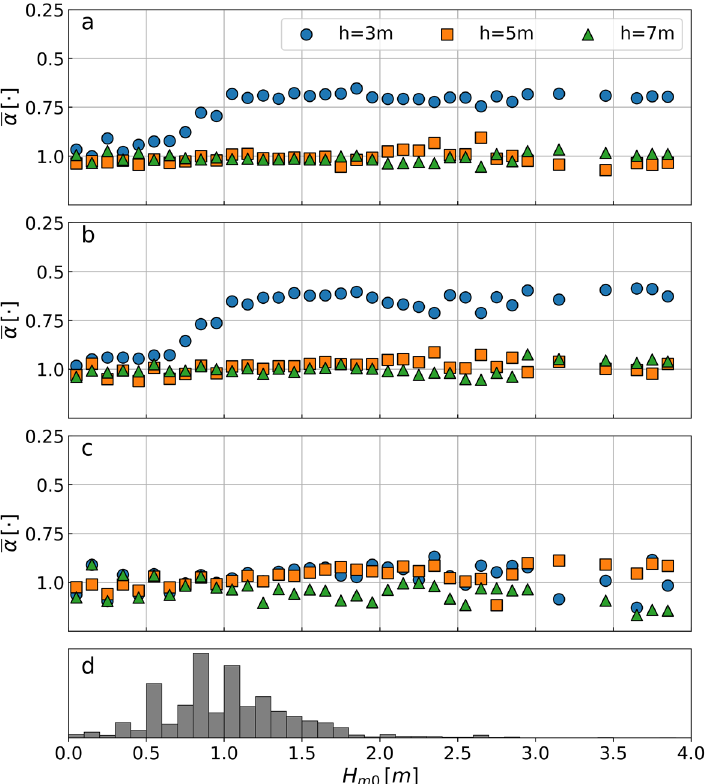
Figure 9. Relative wave power binned by offshore wave height at the South Padre Island site where the blue circles, orange squares, and green triangle markers represent the 3 m, 5 m, and 7 m placement depths, respectively. ( a ) Linear berm; ( b ) undulated berm; ( c ) discrete mounds; ( d ) PDF for offshore wave height.